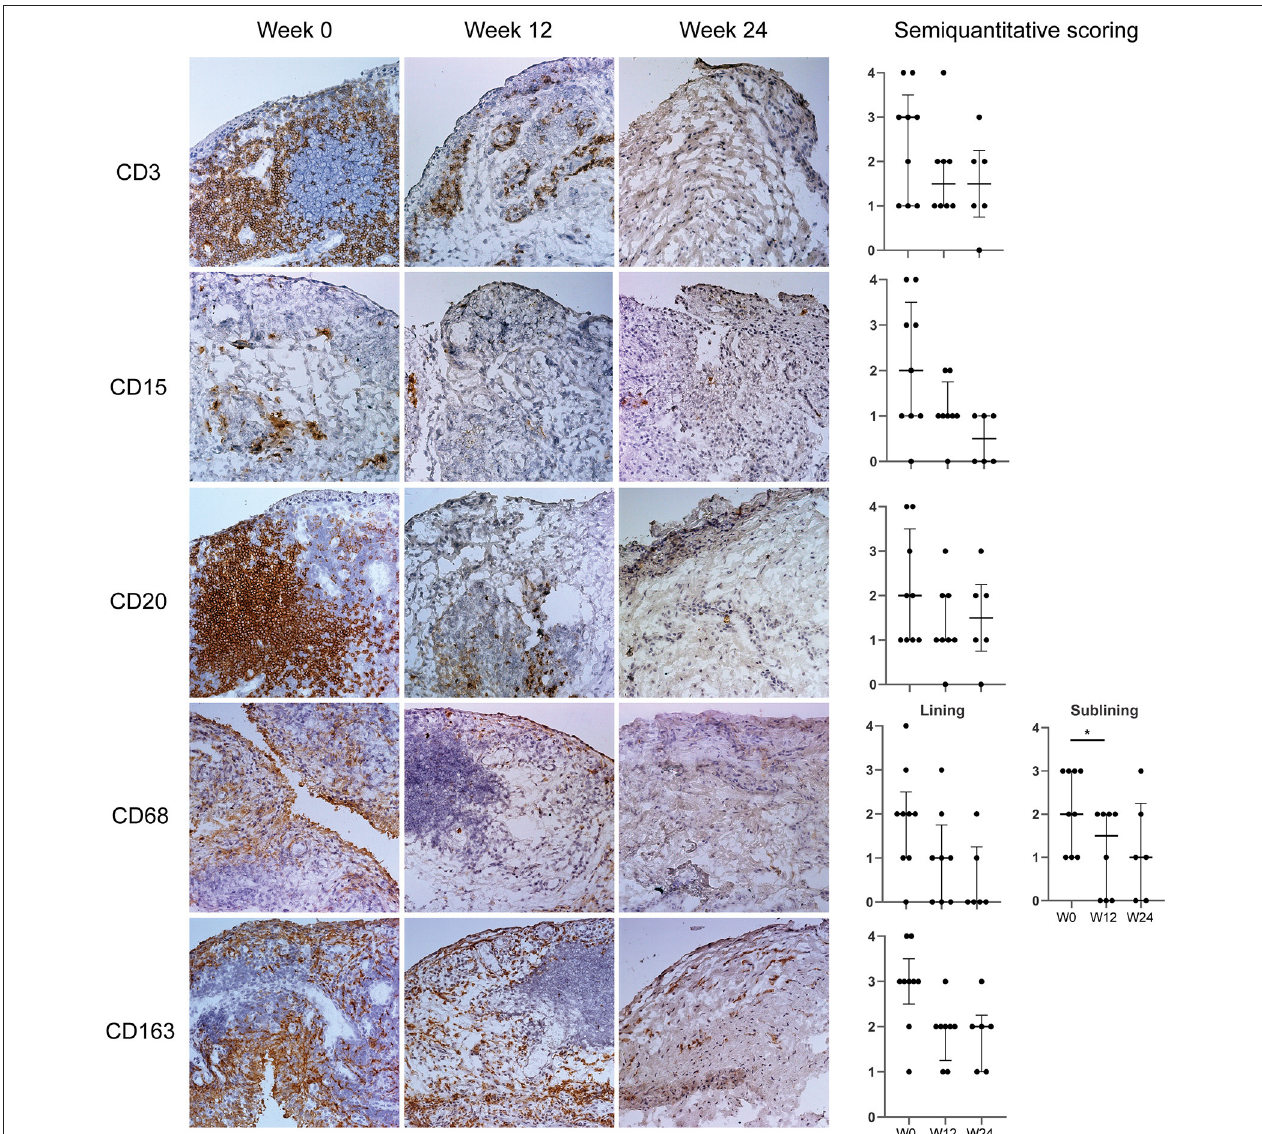
FIGURE 1 | IL-12p40/IL-23p40 blockade by ustekinumab decreases the synovial infiltrate. (Left) Representative paired cryosections of synovial tissue obtained before (Week 0, W0, n = 9) and after 12 (W12, n = 8), and 24 (W24, n = 6) weeks of ustekinumab treatment, immunohistochemically stained for CD3 (T-cells), CD15 (neutrophils), CD20 (B-cells), CD68 (macrophages), and CD163 (alternatively activated macrophages). Original magnification x 20. (Right) Blind semiquantitative scoring. CD68 was scored for lining and sublining separately. Bars show median and interquartile ranges. Numerical decreases are seen for all cells, reaching significance for CD68 sublining macrophages after 12 weeks of ustekinumab treatment. * P <